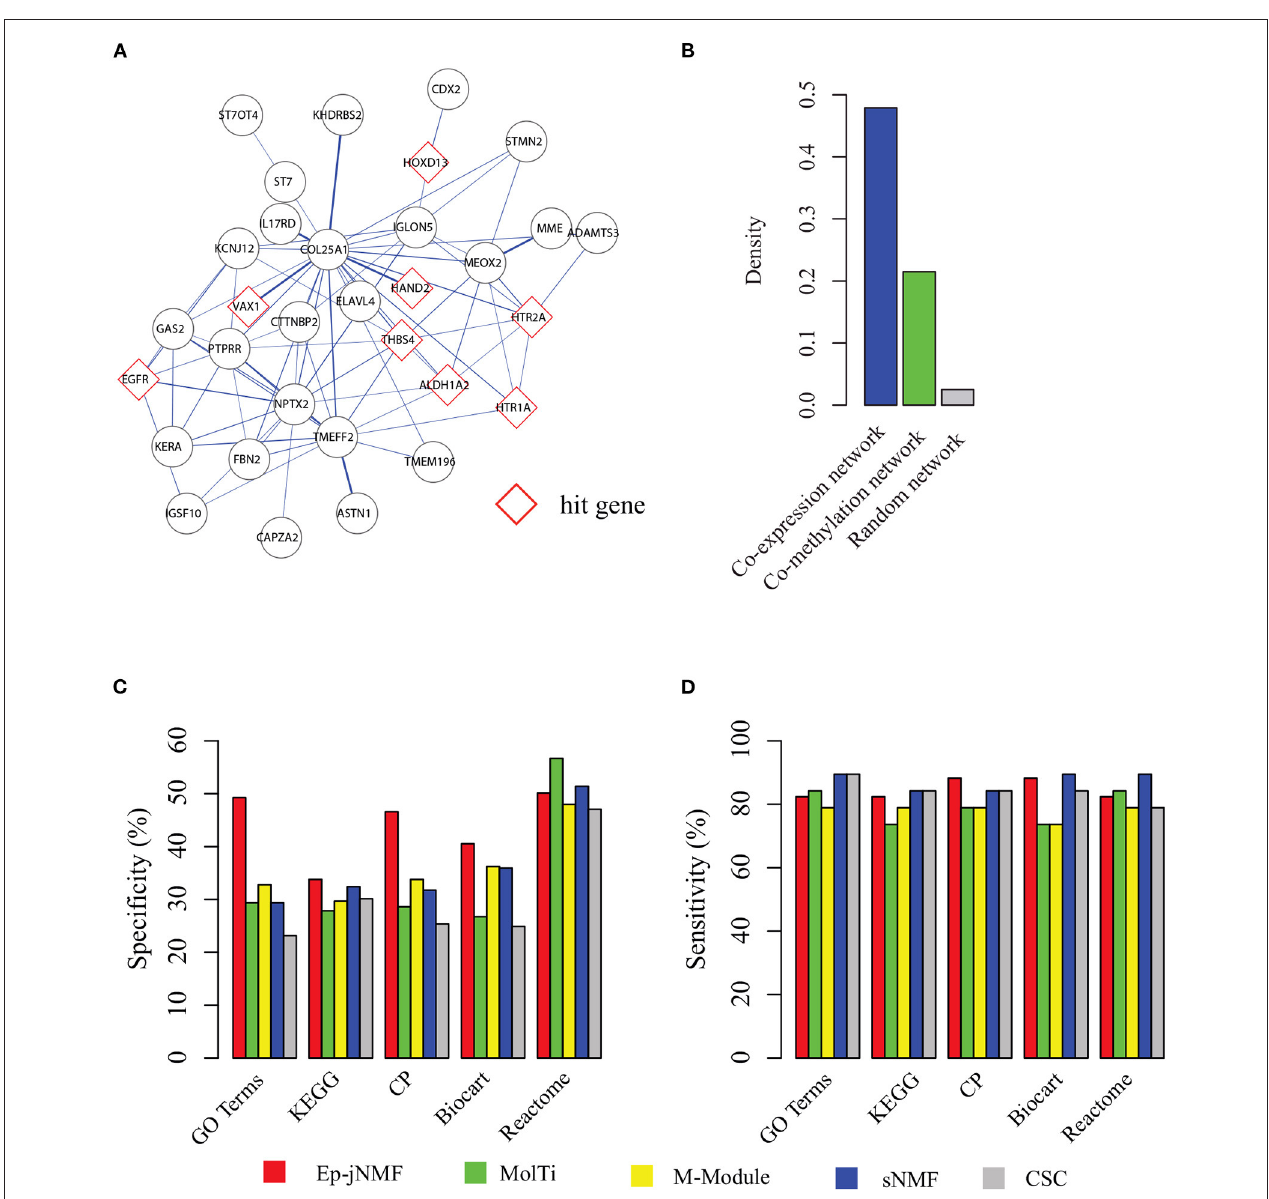
FIGURE 4 | Performance on the cancer networks: (A) a typical epigenetic module predicted by Ep-jNMF with red border color as hit genes; (B) the density of the modules in the co-methylation and co-expression network; (C) percentage of predicted modules enriched by one reference pathways or functions (specificity); and (D) percentage of reference pathways or functions enriched by a predicted